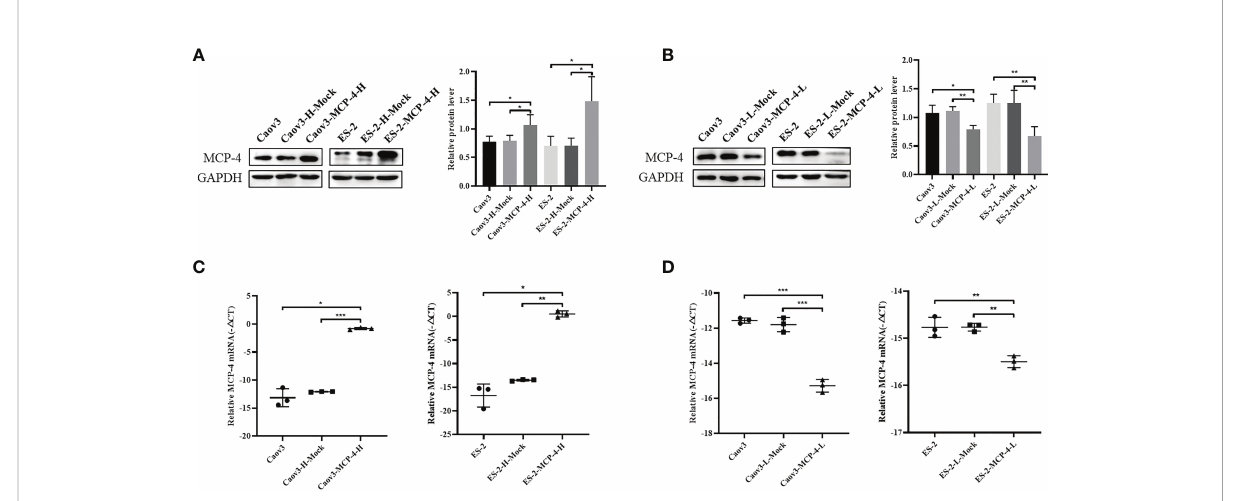
FIGURE 3 The protein and mRNA expression of MCP-4 in the overexpression/inhibition groups. (A, B) Representative images and quantitation of the western blotting showed that the protein expression of MCP-4 in the overexpression/knockdown groups (n = 3). GAPDH was used as an internal control. ( C , D ) The relative MCP-4 mRNA expression in the overexpression/inhibition groups (n = 3). Data are presented as mean ± SD. * P < 0.05; ** P < 0.01; *** P <